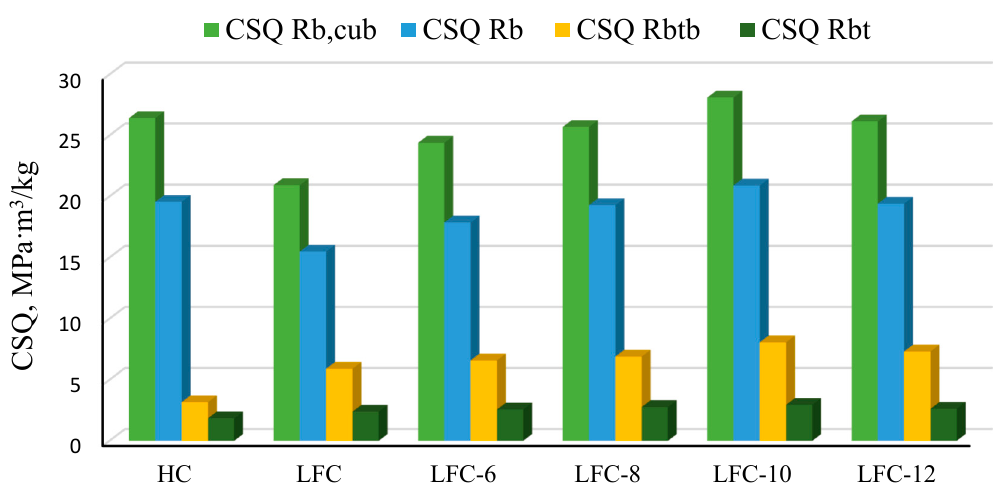
Figure 12. Values of structural quality factors for various types of concrete (HC—heavy concrete; LFC—lightweight fiber concrete; LFC-6—lightweight fiber concrete with MS = 6%; LFC-8—with MS = 8%; LFC-10—with MS = 10%; LFC-12—with MS =